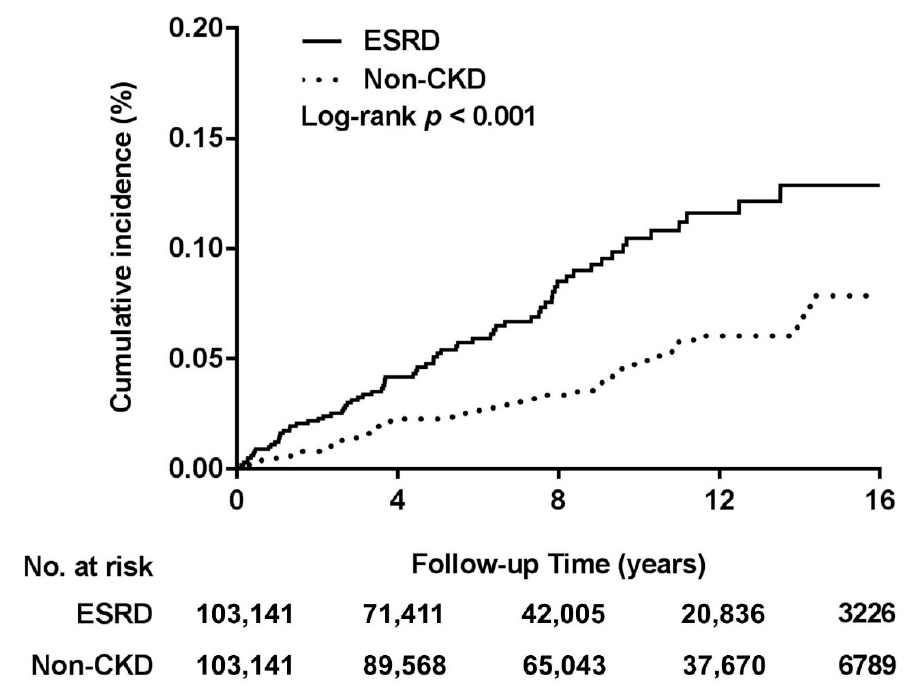
Figure 2. Cumulative incidence of PTA in the ESRD and non-CKD groups. Abbreviations: CKD, chronic kidney disease; ESRD, End-stage renal disease. Table 3. Multivariable Cox proportional hazard regression for the association of ESRD with PTA and covariates.